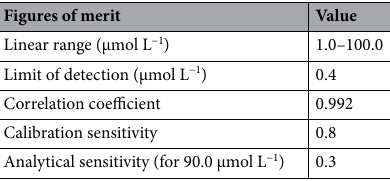
Table 1. The analytical features L for determination of cyanide by using the proposed assay.